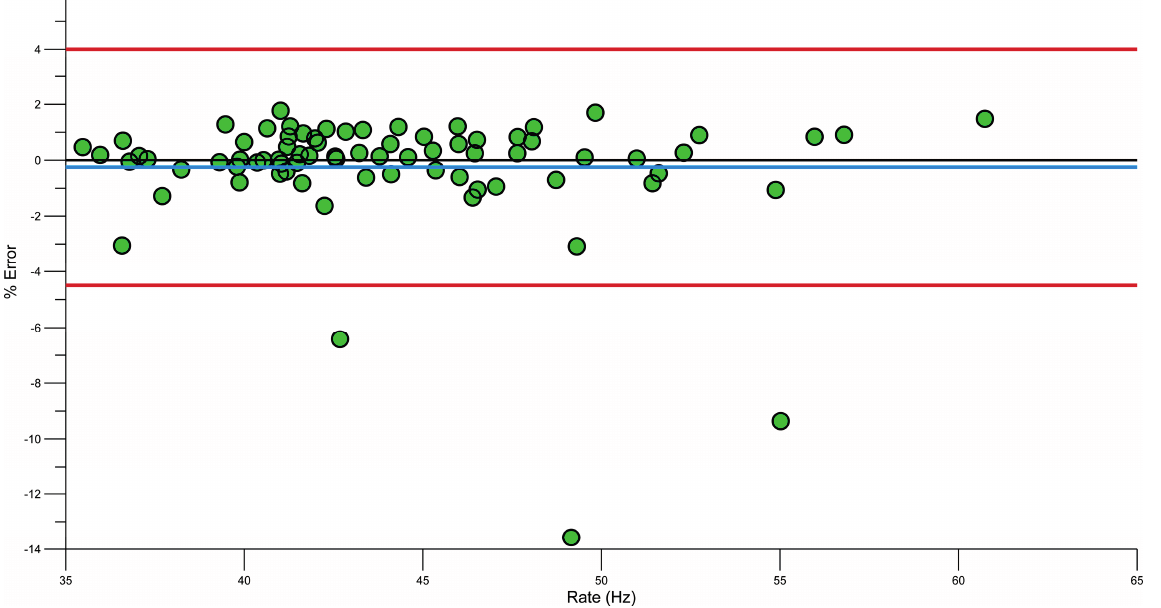
Figure 9. Bland Altman plot showing error in stroke rate (red lines, upper and lower 95% confidence, blue line, systematic bias).